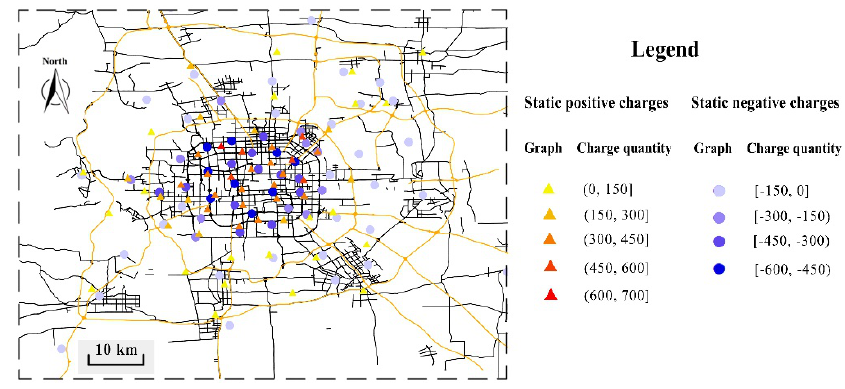
Figure 5. The distribution of the static charges in the case study.